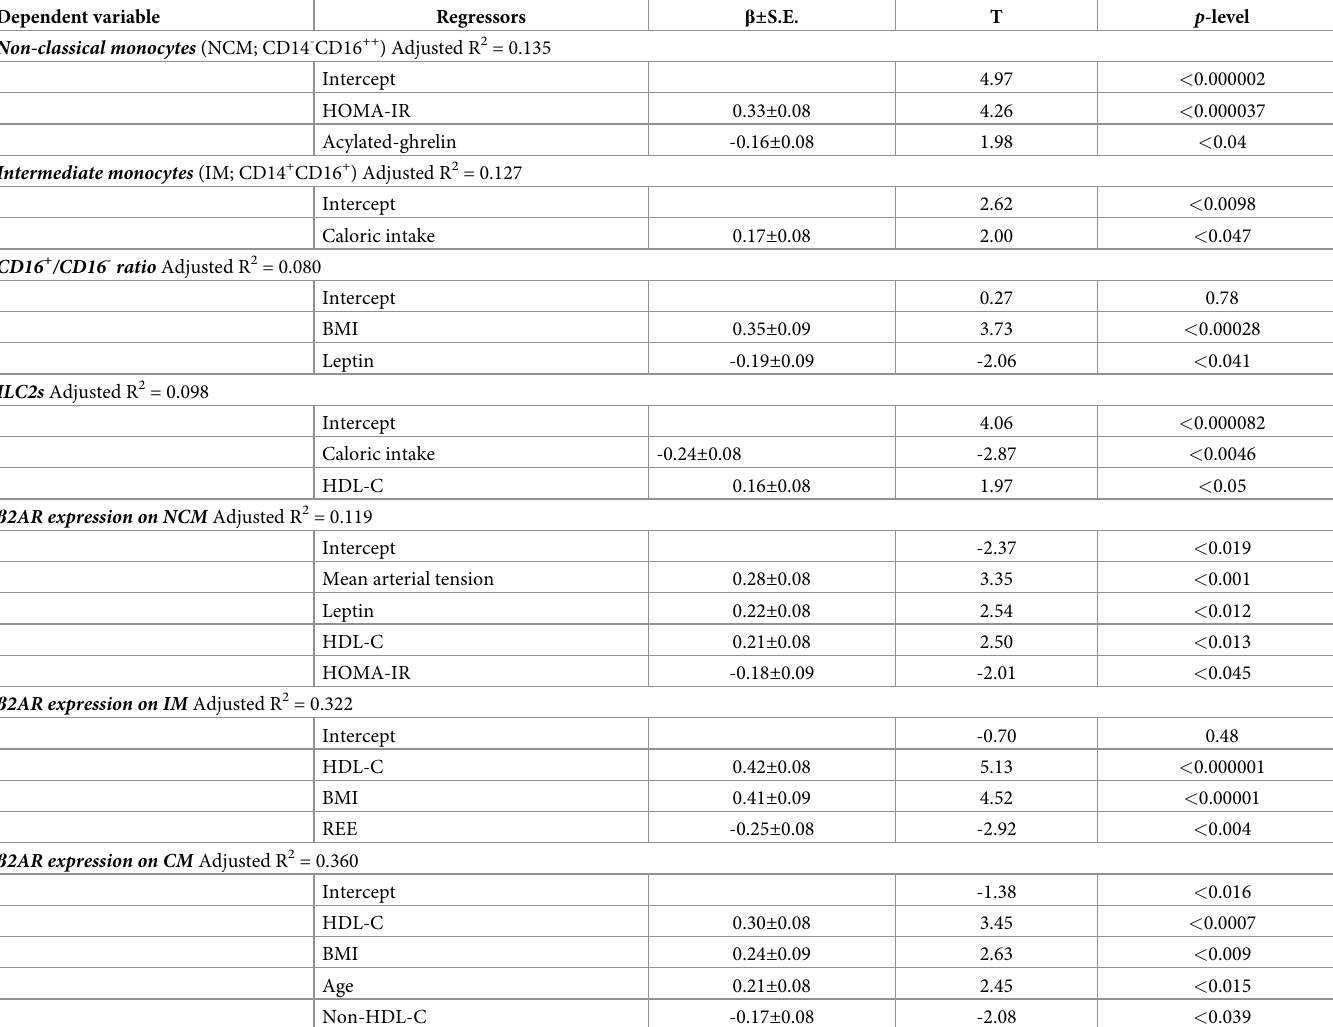
Table 2. Relationships of monocytes subsets with anthropometric, and metabolic features in basal